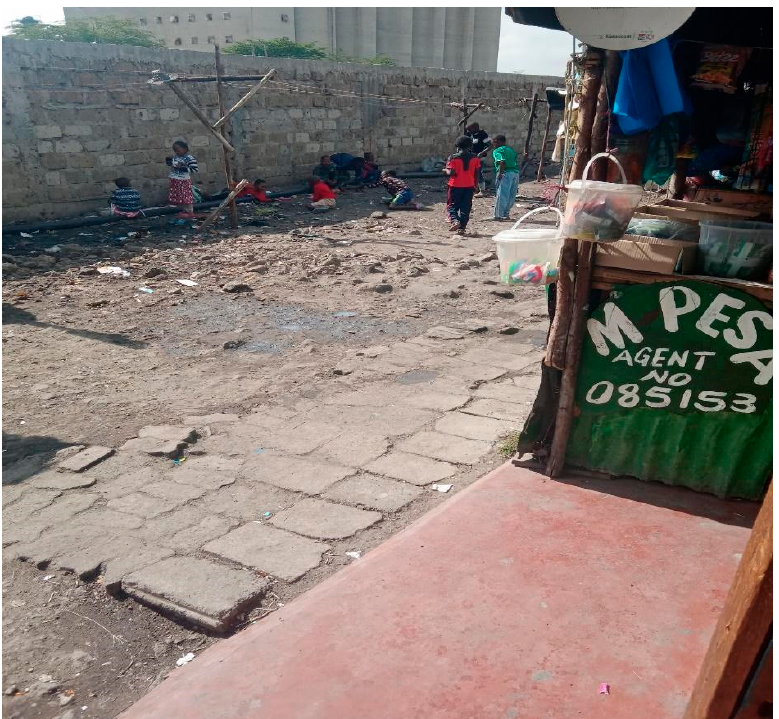
Figure 7. “The government came and put up that wall, to close us in, the people of the Kijiji (referring to Viwandani informal settlement), from the other side of the rail track. So, like when these houses burn, you find that the fire trucks are not able to reach the burning houses…they put up the wall to separate us. You start feeling like you are not a Kenyan, or you feel like you were thrown away and it is like you do not hold any significance” (Daniel, 17-year-old boy, Viwandani).